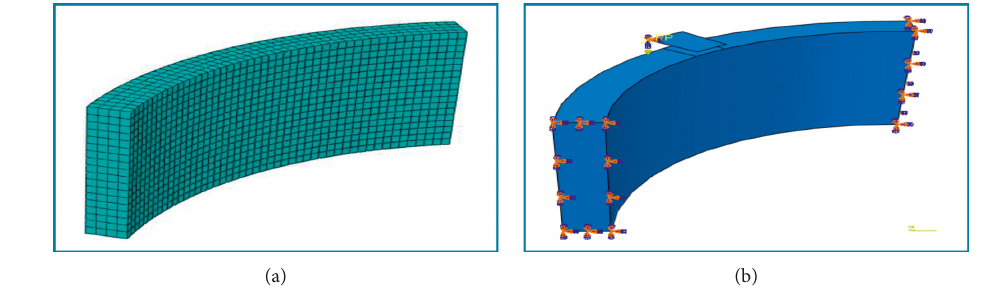
Figure 3: (a) Meshing and (b) loading boundary condition.